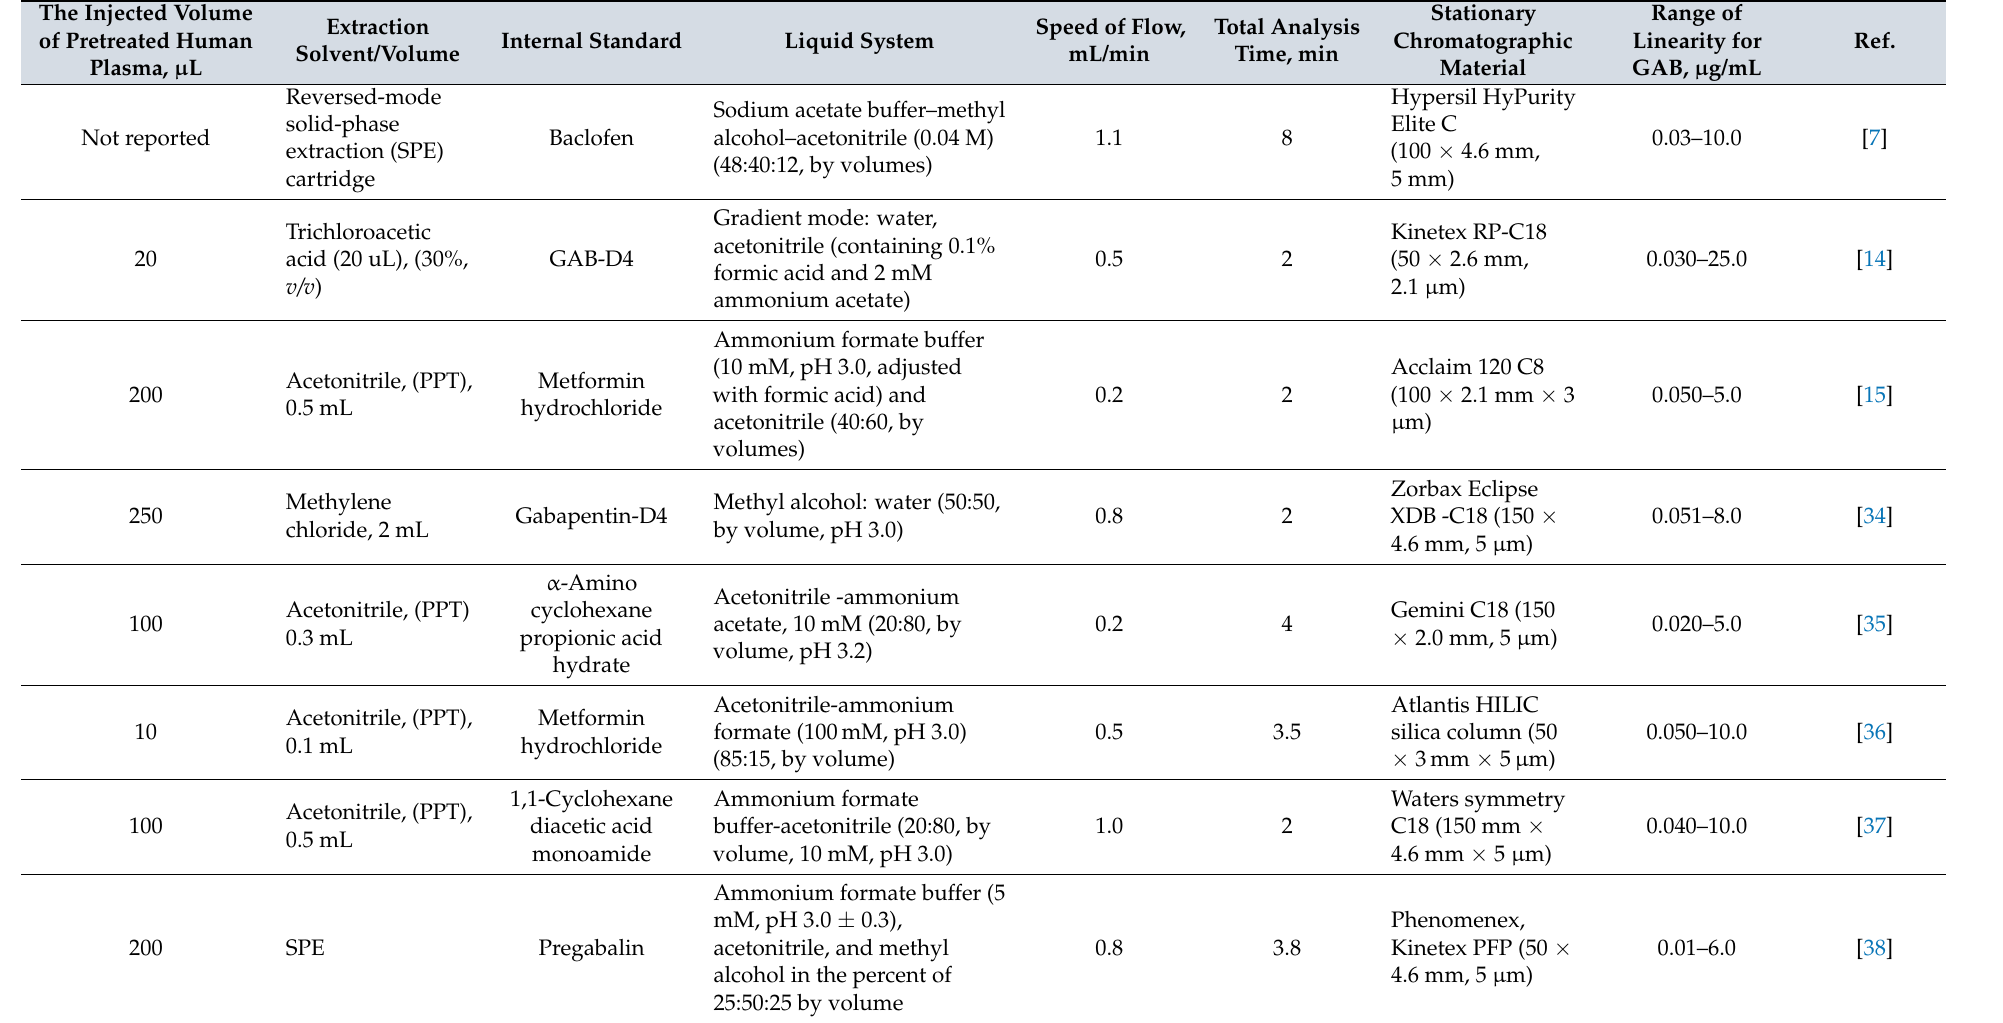
Table 2. Comparison of the various parameters and conditions used by the reported and proposed LC-MS/MS